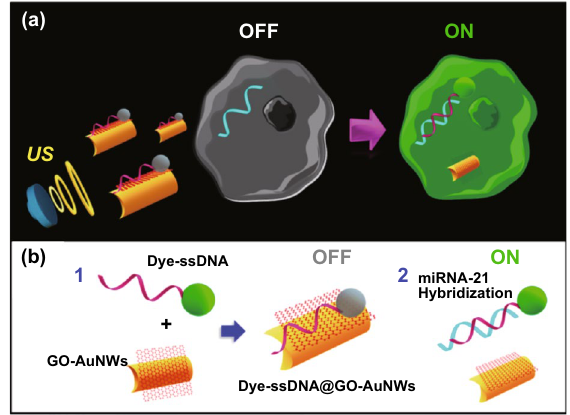
Fig. 6 a Intracellular detection of miRNA in intact cancer cells using ultrasound (US)–propelled nanomotors. b the “OFF–ON” fluorescent switching system for the specific detection of miRNA-21 in intact cancer cells, and steps involved immobilization and quenching of the dye fluorescence. Adapted from Ref. [91] with permission, copyright American Chemical Society,